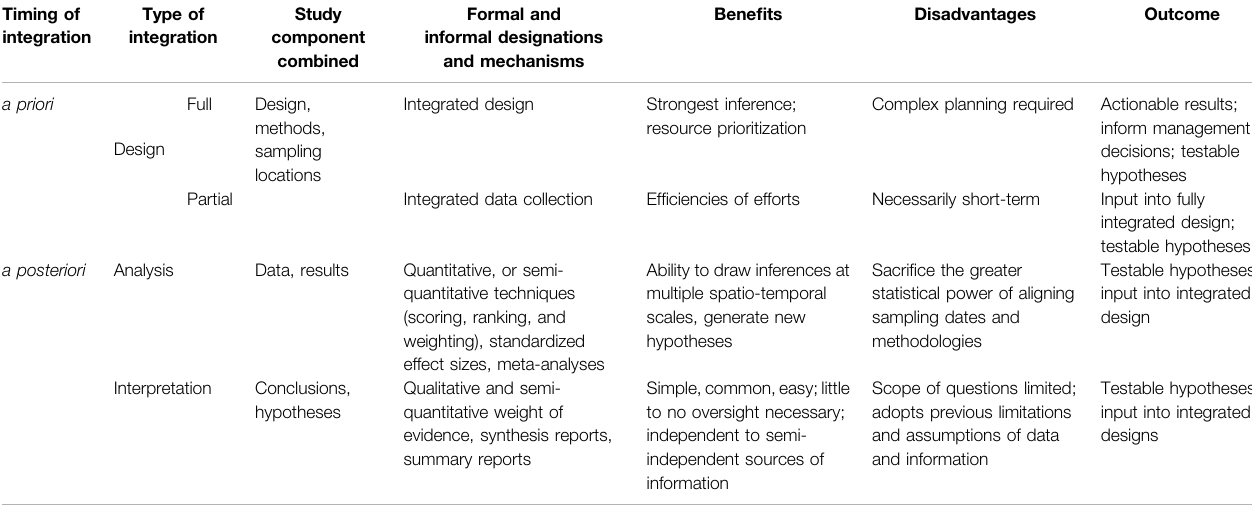
TABLE 2 | Attributes to consider in theintegration ofmonitoring “ early ” (e.g., during design, a priori) or “ later ” (e.g., during interpretation, retrospectively, aposteriori) phases of the program and typical qualities (e.g., high, low) of applying integration during those study phases. General attribute Strength of